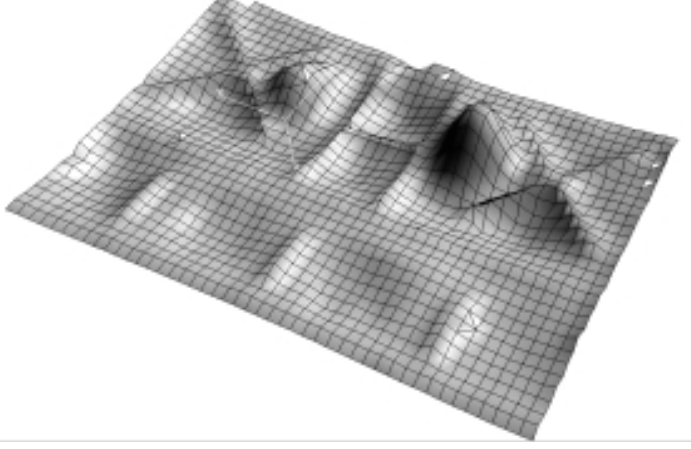
Fig. 14. Mode shape at 444 Hz.